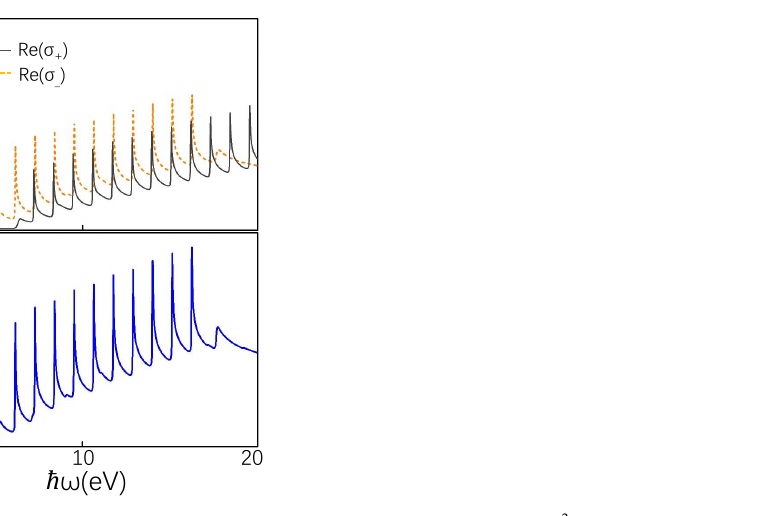
Figure 5. ( a ) The absorption part of the optical conductivity (in units of e 2 light. The parameters are the same as in Figure 3c. ( b ) Power spectrum (in units of e 2 energy. The parameters are the same as ( a